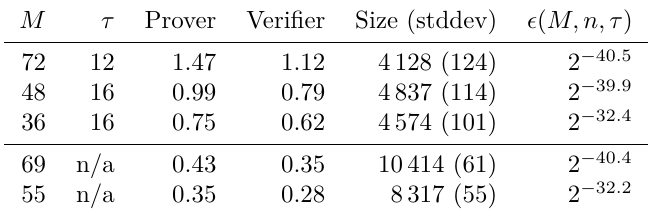
Table 9: The first half of the table shows parameter sets and benchmarks for the interactive Picnic3 ID scheme, with N = 16 and primitives from the L1 security level. The second half gives parameters and performance for interactive Picnic1. Times are in milliseconds and sizes are in bytes. M τ